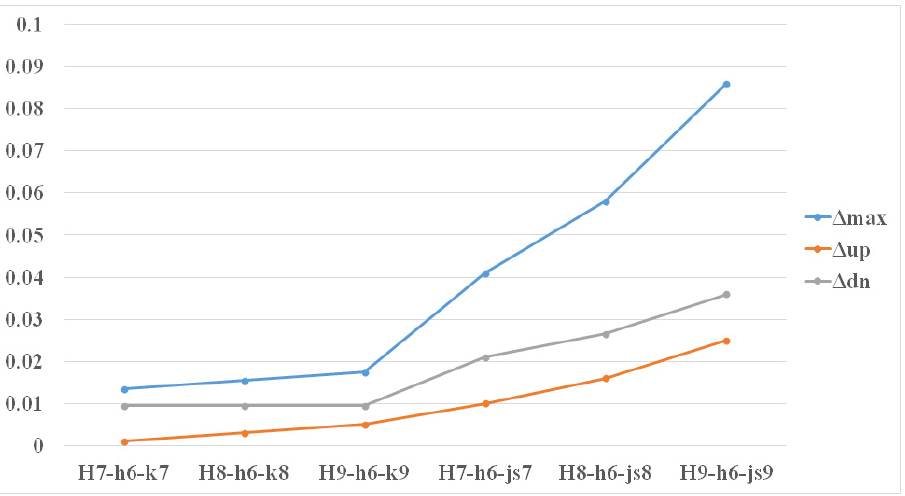
Figure 6. Change of the clearances in the engagement when manufacturing the external profile disk by the H fit.